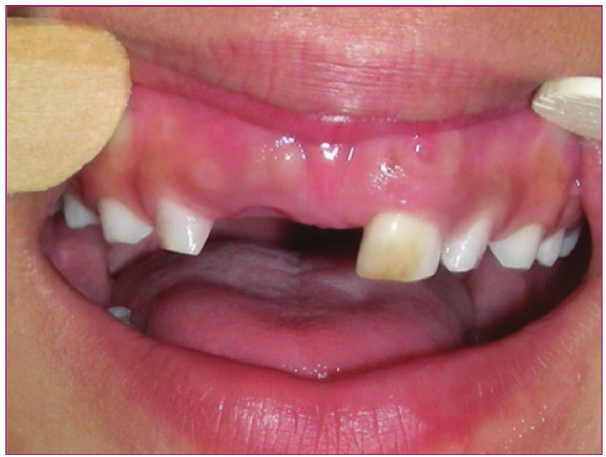
Figure 1 - Clinical aspect of patient with Hypophosphatemic